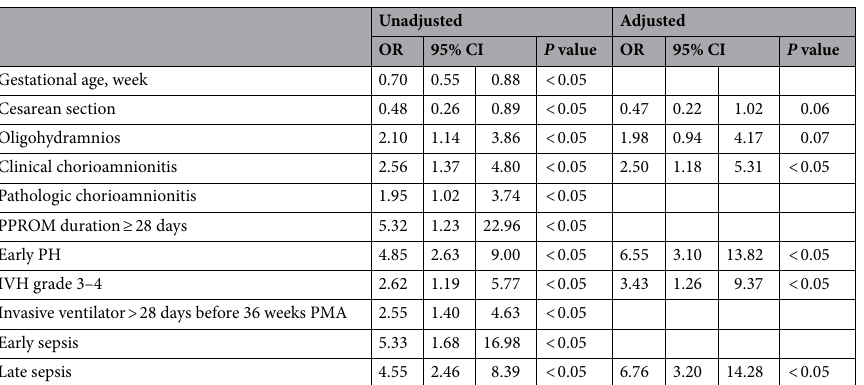
Table 3. Risk factors associated with primary outcome of death prior to 36 weeks PMA or BPD associated late pulmonary hypertension. PH pulmonary hypertension, PMA postmenstrual age, PPROM preterm premature rupture of membranes, IVH interventricular hemorrhage, CI confidence interval.